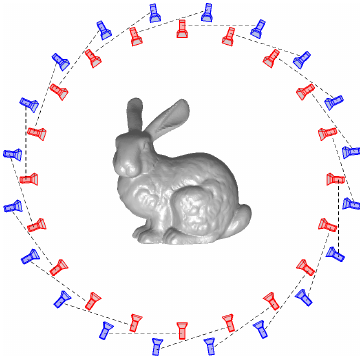
Figure 4. Visualization of one of the circles from our camera–projector setup. In all experiments, we used three circles with 20 cameras each. Red indicates a camera and blue indicates a projector. The dotted lines show which cameras and projectors belong together.